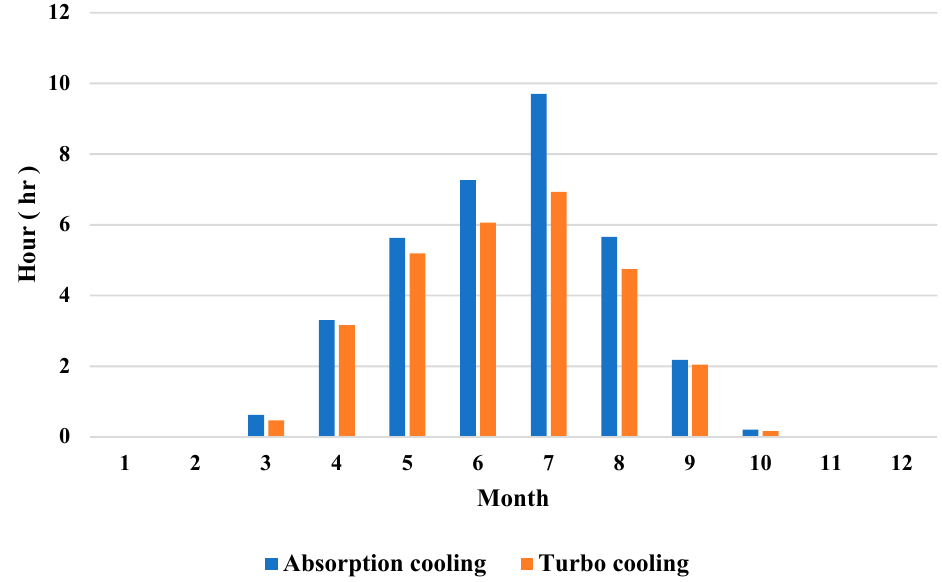
Figure 5. Monthly averaged daily operation hours for turbo and absorption chillers for Case A.